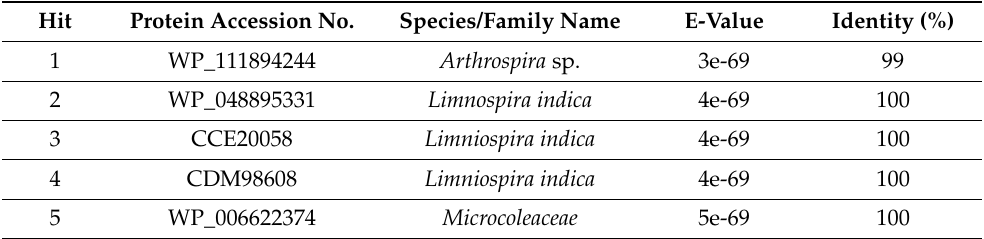
Table 5. Top 5 BLASTp results for the predicted PAD protein from the mottled brittle starfish ( Ophionereis fasciata ) genome (all with 100% query